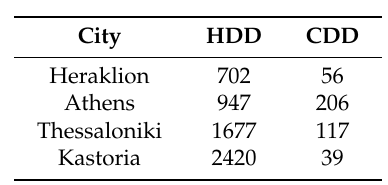
Table 1. Annual Heating Degree Days (HDD) and Cooling Degree Days (CDD) for the representative cities of the four Greek climatic zones 1